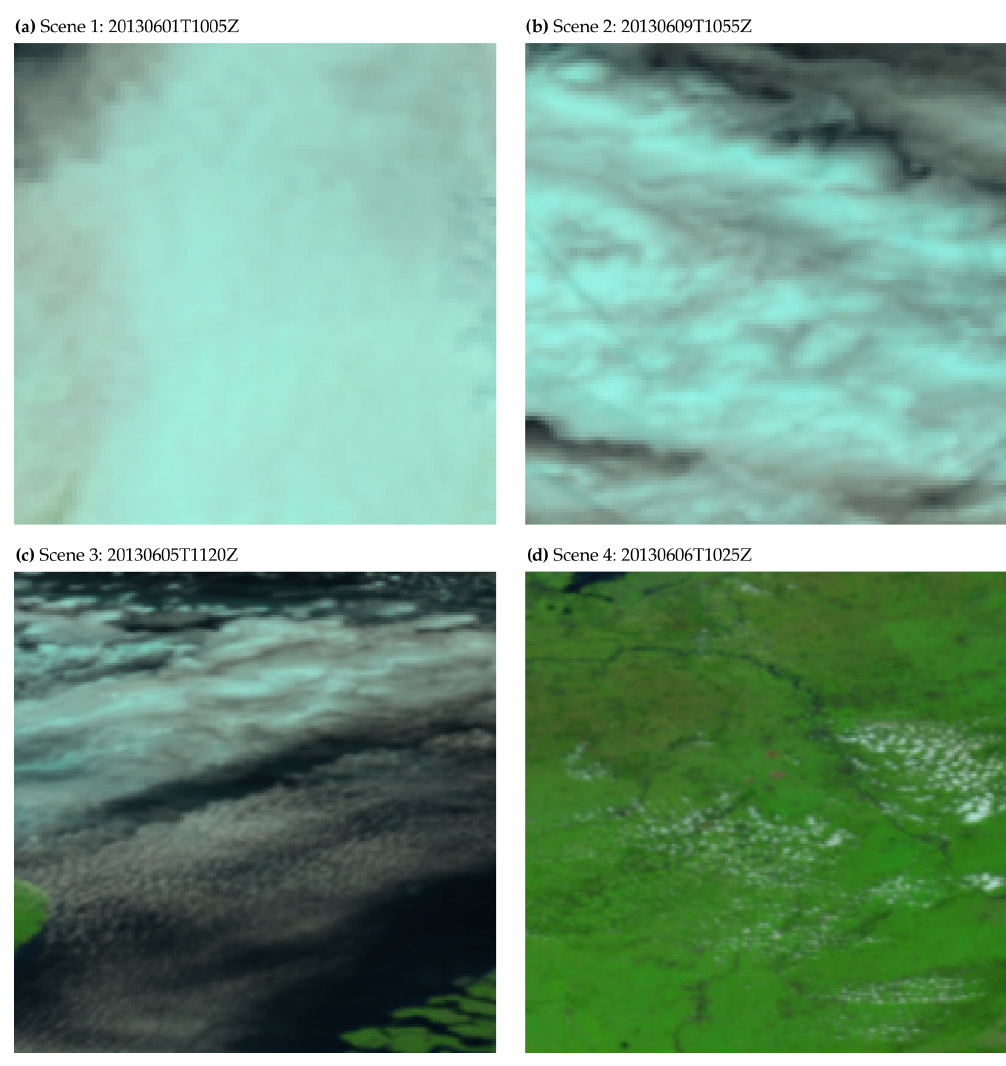
Figure 6. (a) RGB composite image of remapped MODIS channel 6, 2, and 1 reflectances at the horizontal resolution of SEVIRI’s HRV channel at a horizontal scale of 1km × 1km at the subsatellite point. Data are from example scene 1 sampled on 1 June 2013 at 10:05UTC. (b) – (d) Same as (a) but for example scenes 2 to 4, sampled on 9, 6, and 5 June 2013 at 10:55, 11:20, and 10:25UTC,